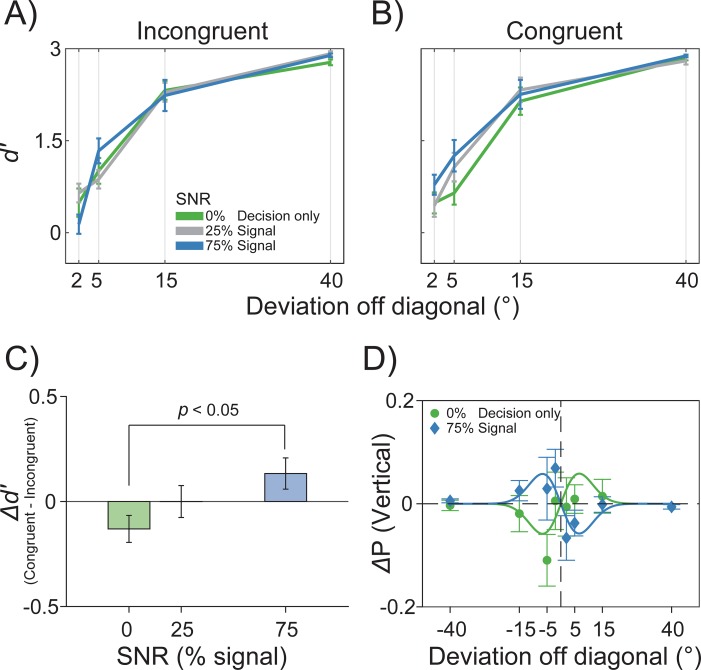
Results of the Vertical/Horizontal task in Experiment 4.(A–B) Perceptual sensitivity (d’) as a function of the increasing deviation of the Gabor from oblique and of the SNR in the preceding Left/Right task, for both the Incongruent (A) and Congruent (B) conditions (see Methods for a detailed description). (C) The difference in the overall d’ between Incongruent and Congruent trials (collapsed over deviations) revealed the effect of previous stimuli (75% SNR) and past decisions in the absence of stimuli (0% SNR): Previous stimuli increased the sensitivity to changes around their orientation; previous decisions had the opposite effect. (D) The raw average proportions of “vertical” responses for SNR 0 and 75% (Incongruent minus Congruent) showed a DoG-like pattern of opposite sensitivity changes. The raw data are available at https://doi.org/10.5281/zenodo.2544946. DoG, derivative of Gaussian function; SNR, signal-to-noise ratio.